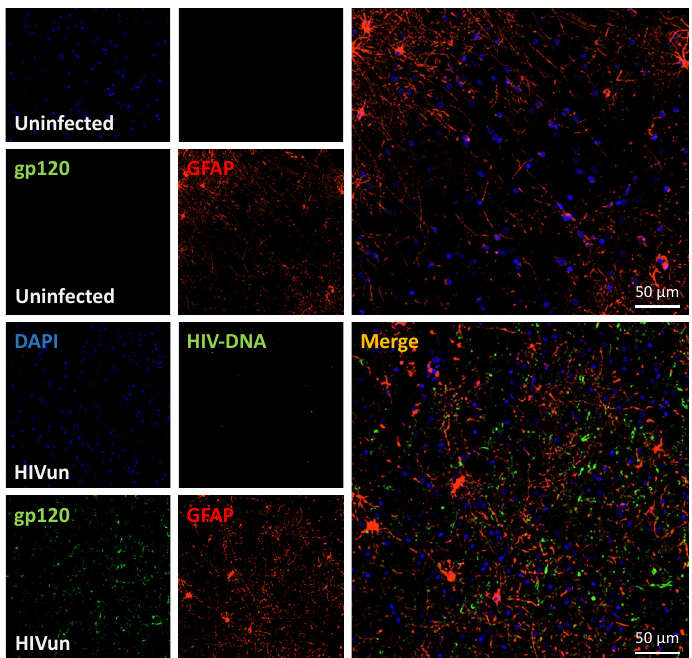
Figure 1. Detection of gp120 proteins in the cortex of MND. Examples of cortical sections from un- infected and HIV-infected individuals with MND (samples are from NNTC, viral load <40 cop- ies/mL). Sections were deparaffinized, stained for nuclei (DAPI), gp120 biotinylated antibody (Cy3, NIH AIDS Reagent Program) and Iba-1 (Cy5), and analyzed by confocal microscopy using a Nikon A1R microscope and NIS elements. Arrows and insets show that few microglial cells are positive for gp120 and are only detected in MND. Data were reproduced in two additional cases. (In collab- oration with Dr. E. Eugenin, UTMB, Galveston, TX, USA.)